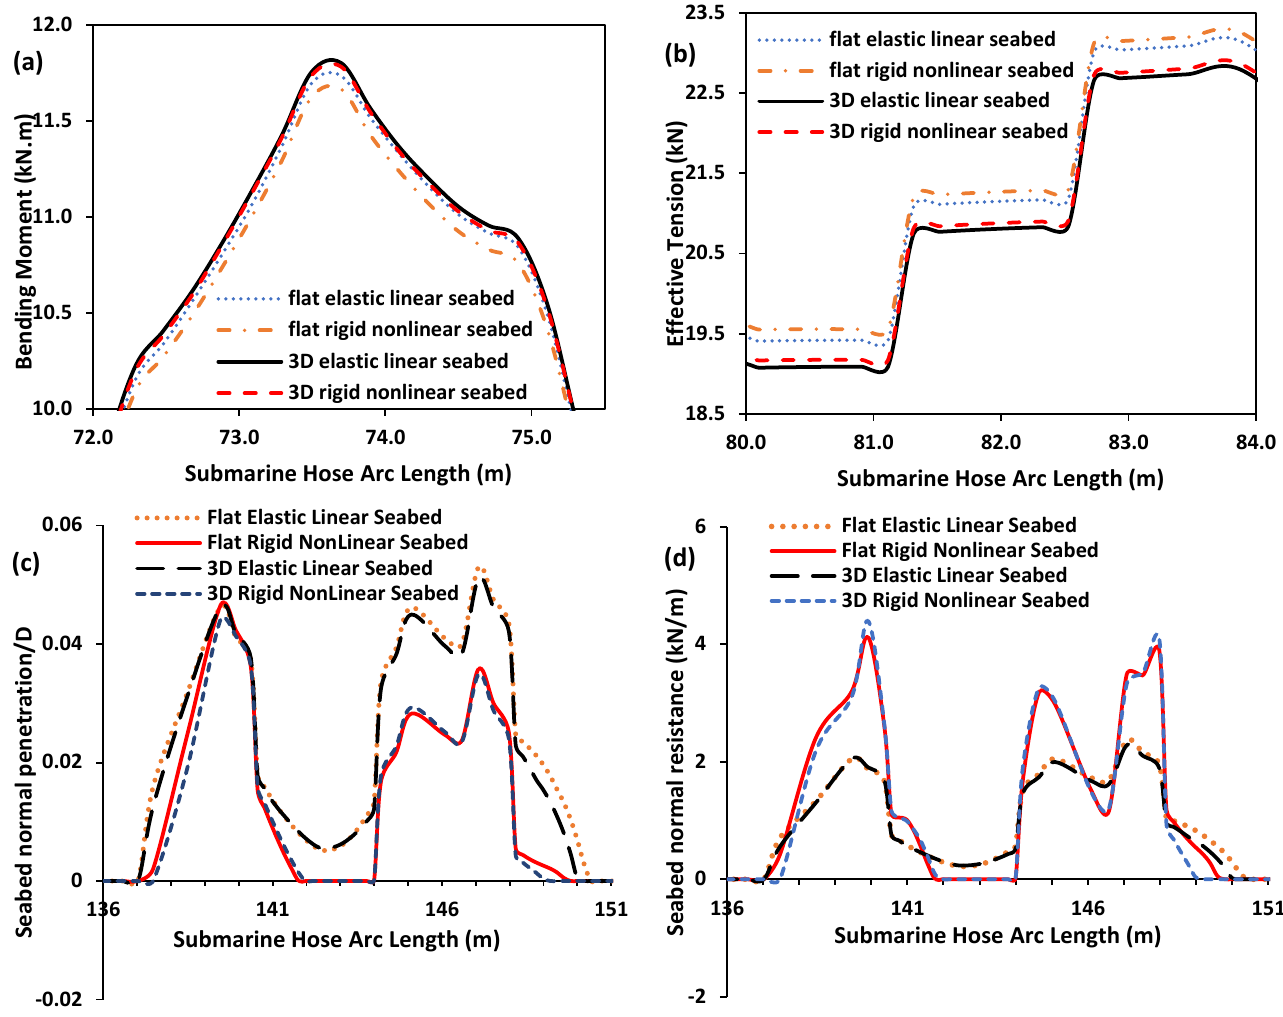
Figure 33. Influence of Seabed Soil Model on the submarine hoses, for ( a ) Bending moment, ( b ) Effective Tension, ( c ) Seabed normal penetration/D, and ( d ) Seabed normal resistance.